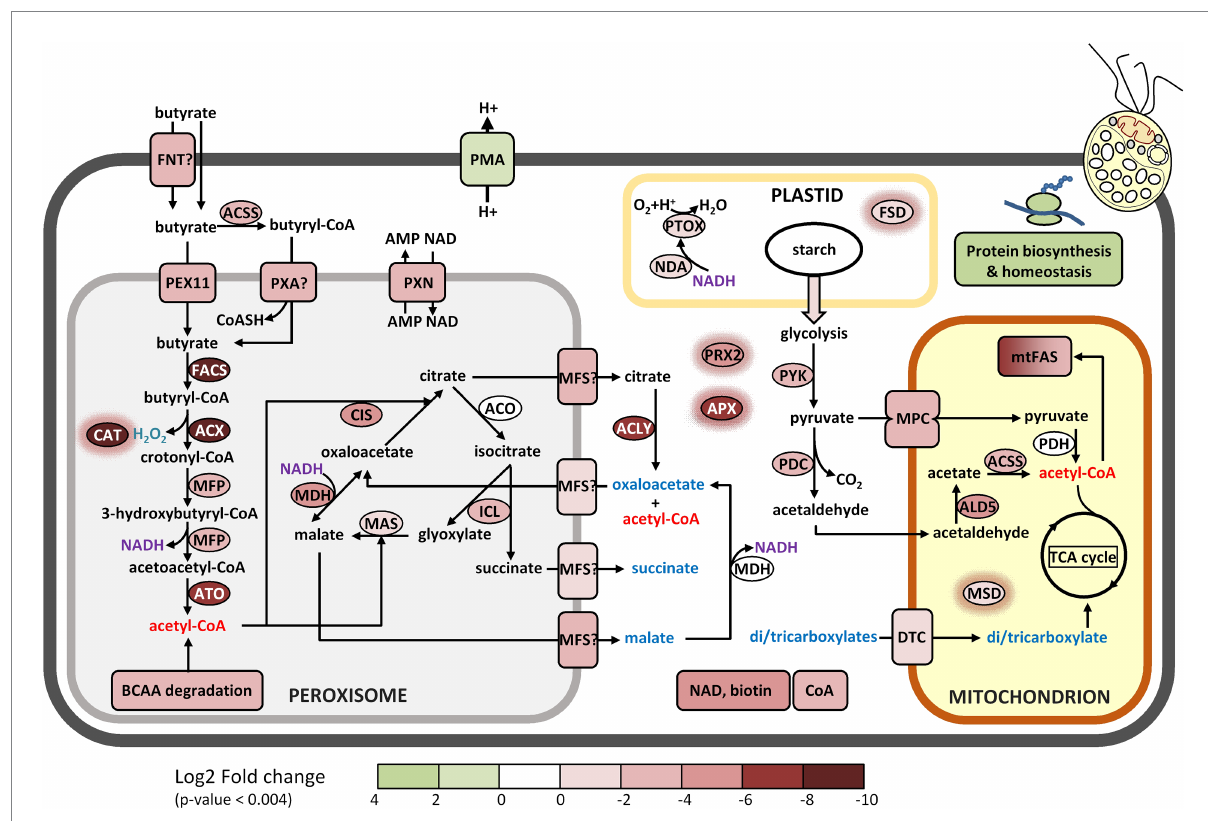
FIGURE 6 Proposed metabolic reconstruction of the assimilation pathway of butyrate based on FC values and targeting predictions. The log2 FC acetate/butyrate value is indicated by the color codes. All di/tricarboxylic acids that may be imported into the mitochondria are indicated in blue. Enzymes with a red halo are involved in antioxidant defense. Enzymes codes and further information can be found in Table 1 and the Supplementary Table